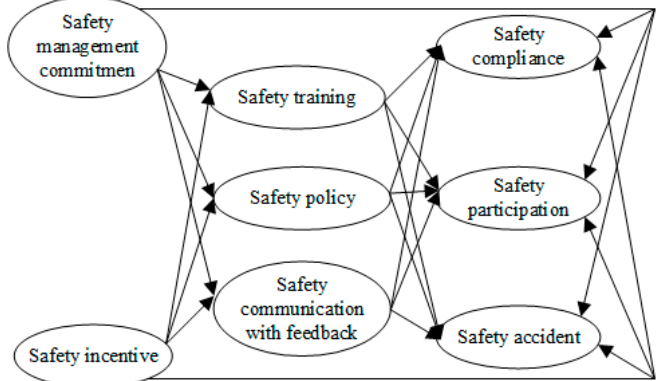
Figure 3. The partial mediation model of leadership behaviours’ effects on safety performance (the first model).